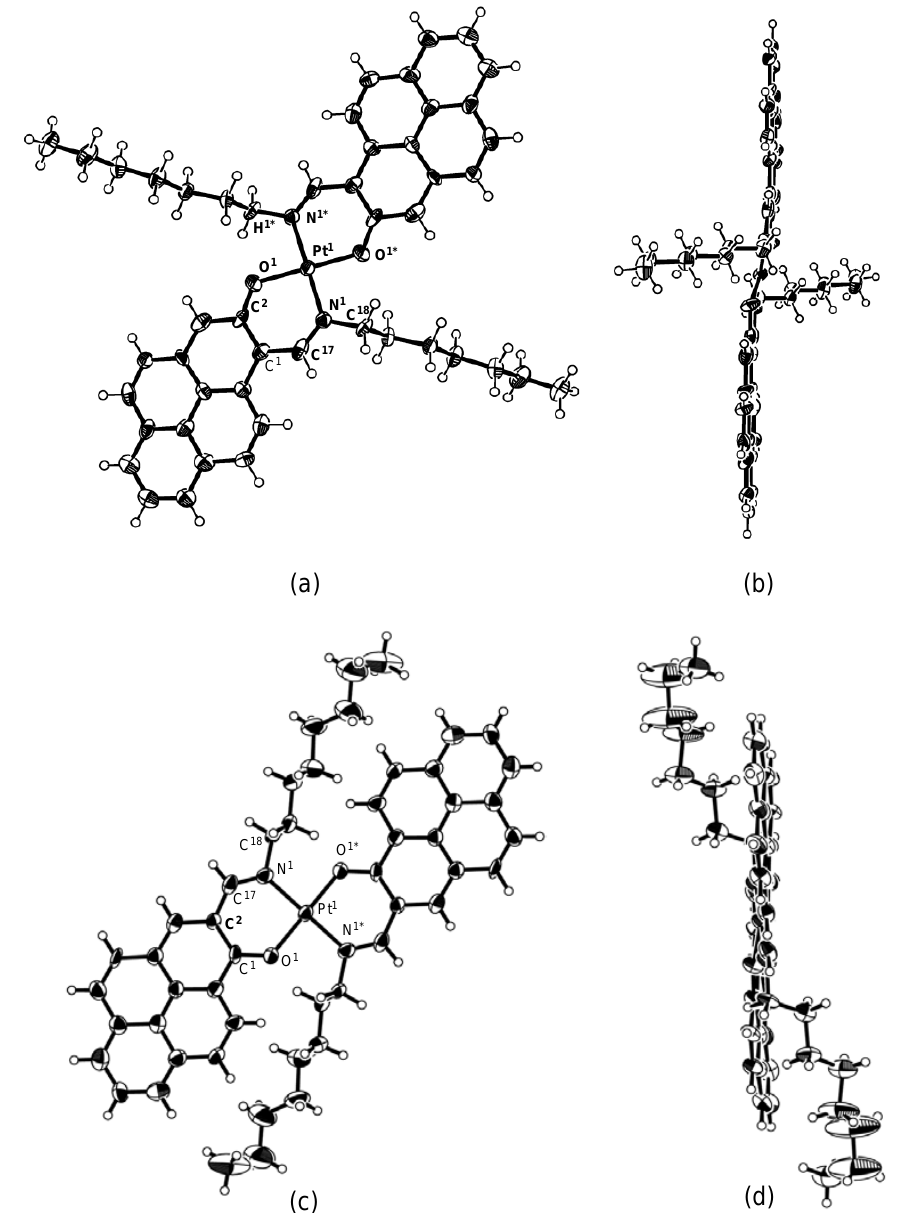
Figure 1. Molecular structures of 2(Pt) and 1(Pt) : ( a ) top view of 2(Pt) ; ( b ) side view of 2(Pt) ; ( c ) top view of 1(Pt) ; ( d ) side view of 1(Pt) . The thermal ellipsoids are scaled to a 50% probability level.